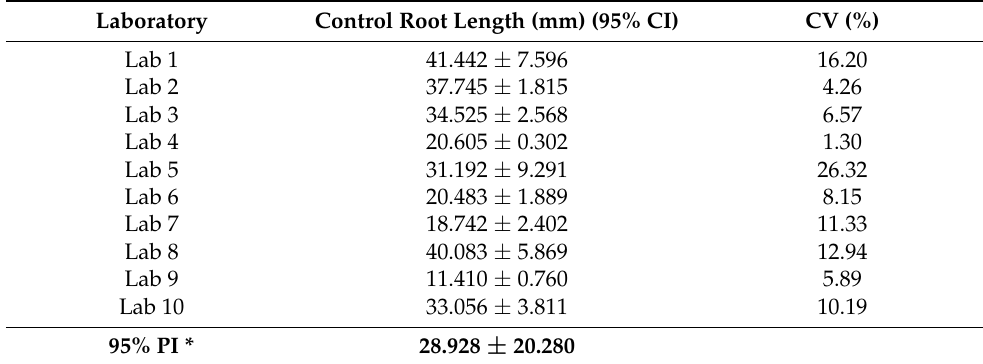
Table 3. Interlaboratory precision of control values of root length in Lemna minor .